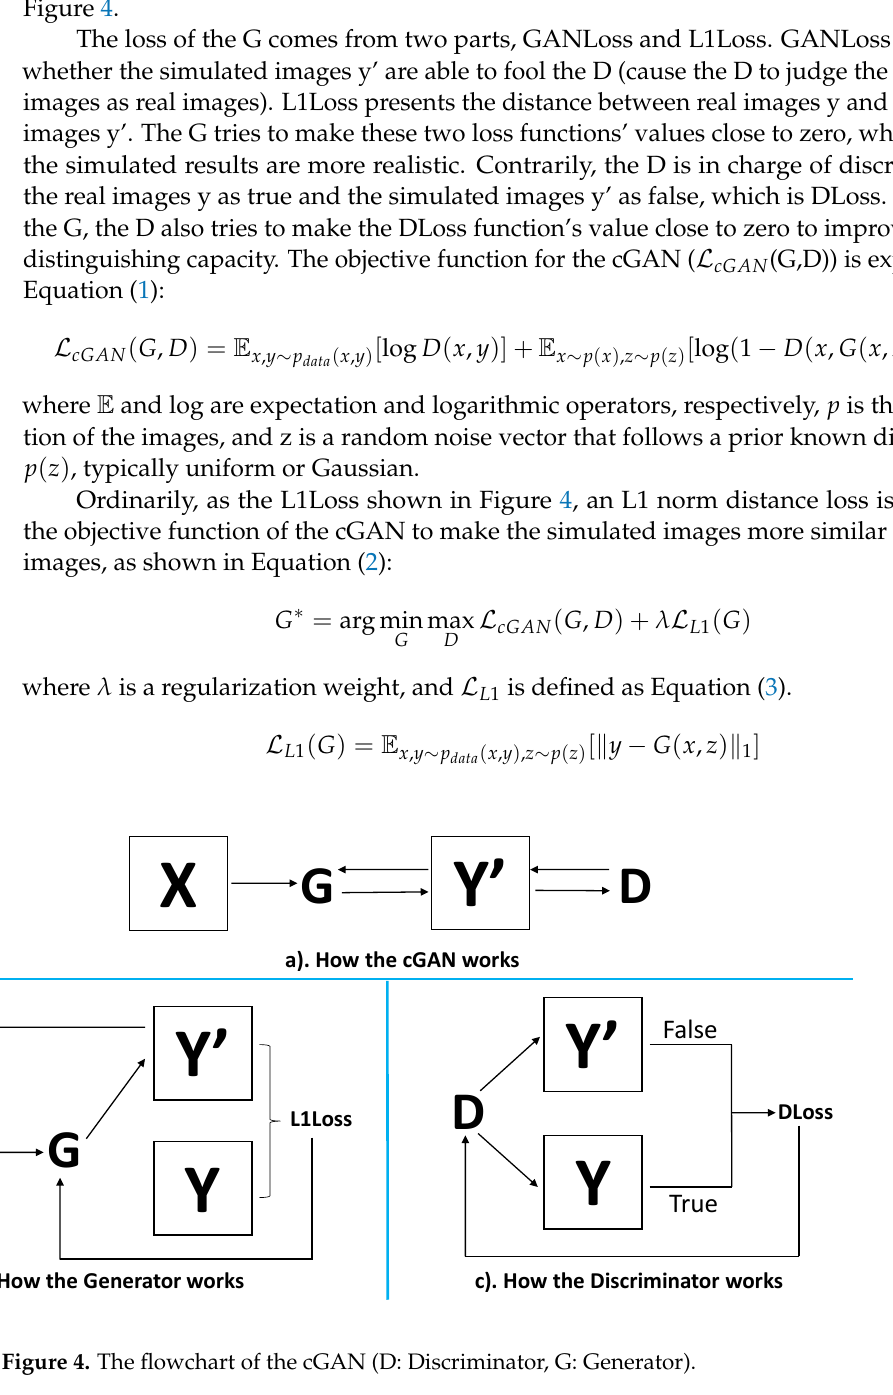
Figure 4. The flowchart of the cGAN (D: Discriminator, G: